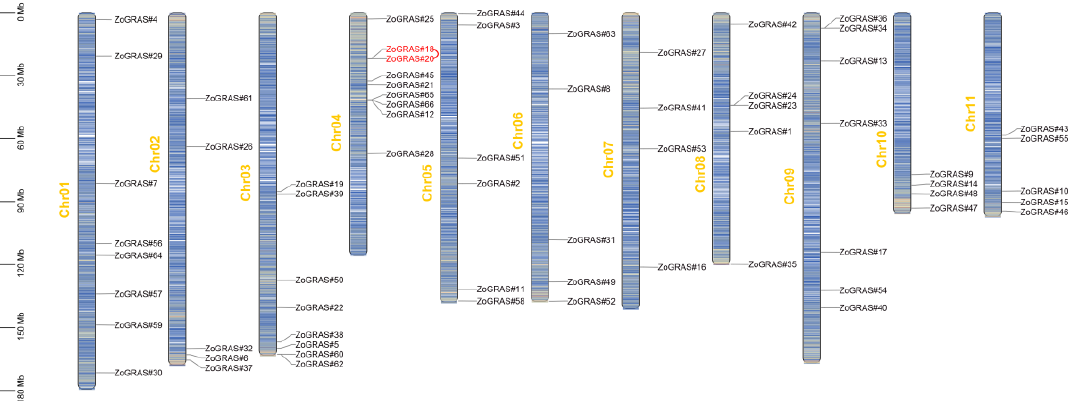
Figure 2. The chromosomal distribution patterns of ginger GRAS genes. GRAS gene pairs resulted from tandem duplication event are connected with red lines. Characters in yellow are the chromosome names. The color gradient of chromosomes from blue to red represent gene density from low to high. Blank area represents lack of gene distribution on chromosomes.